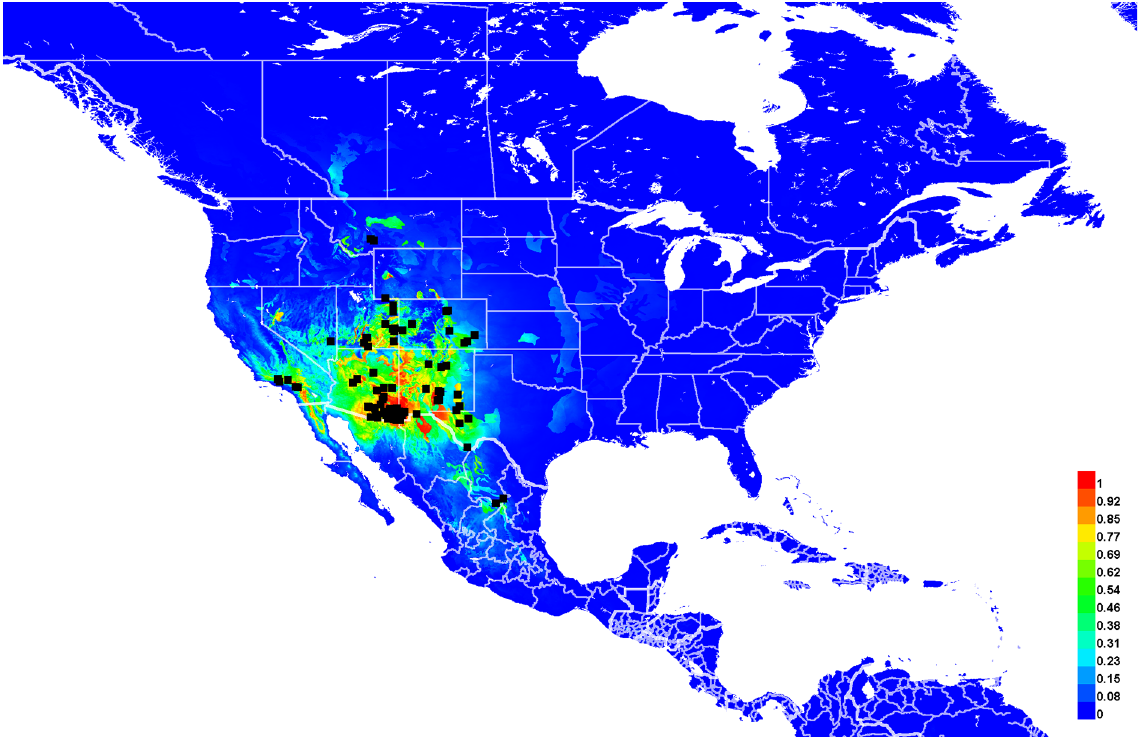
Fig. 30. Georeferenced collection records of Lasioglossum ( D. ) clematisellum (Cockerell, 1904) (black squares) and predicted distribution by maximum entropy ecological niche modeling in Maxent (colour shading). Warmer colours indicate higher cloglog probability of